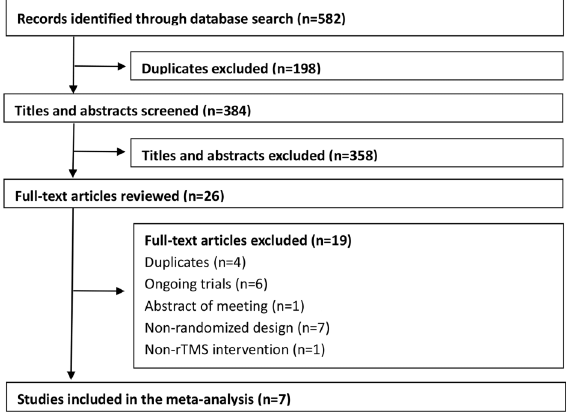
Figure 1. Flow chart of the screening